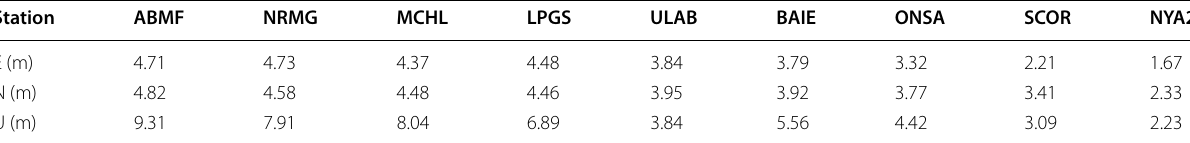
Table 4 RMSEs of kinematic Doppler positioning solutions at nine stations for scheme 1 Station